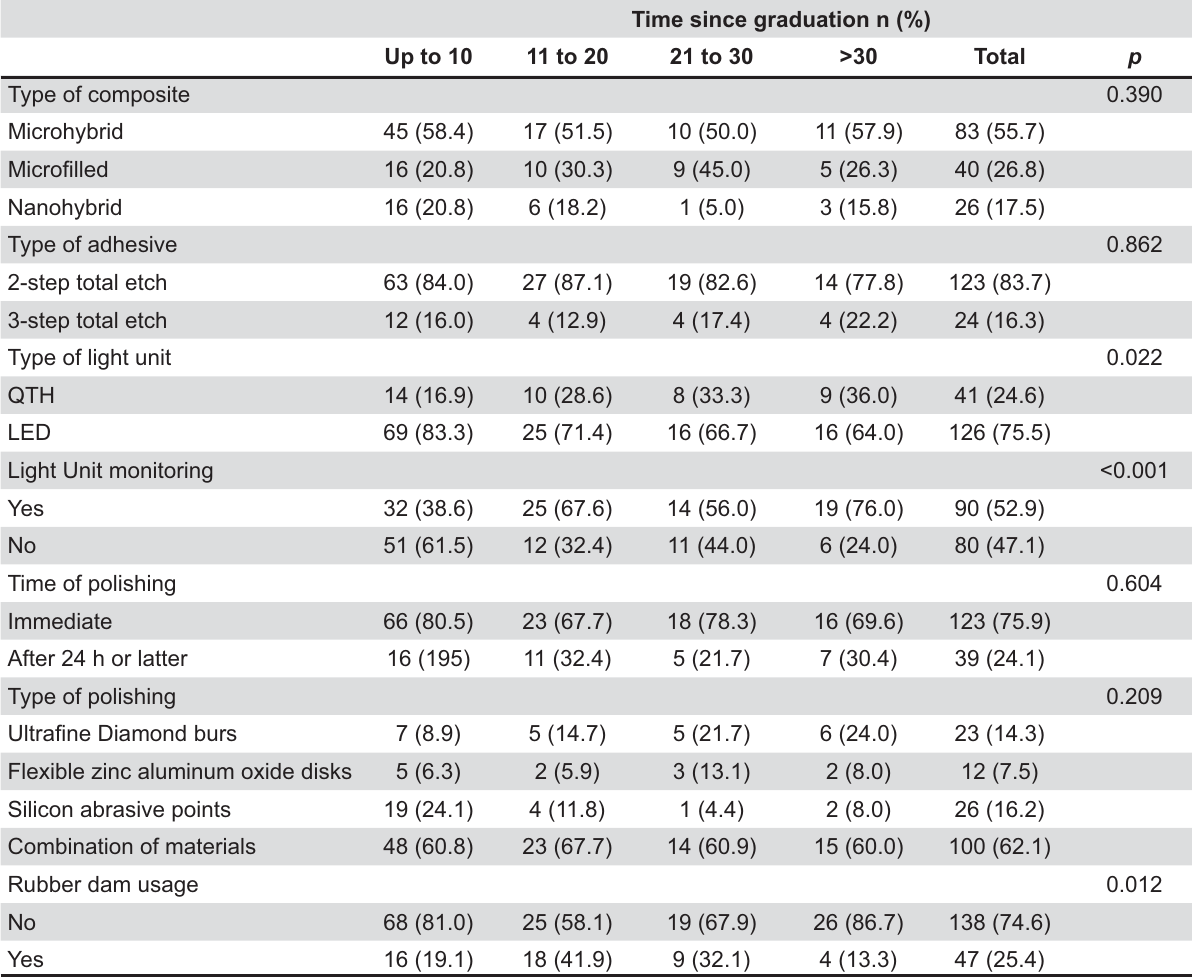
Table 2- Association between the time of clinical practice (since completing dental school) of dentists and variables related to practices for anterior composite